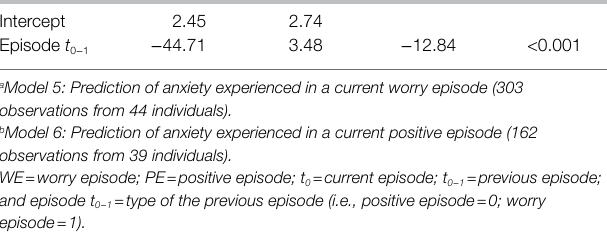
Model 6: Anxiety from t 0